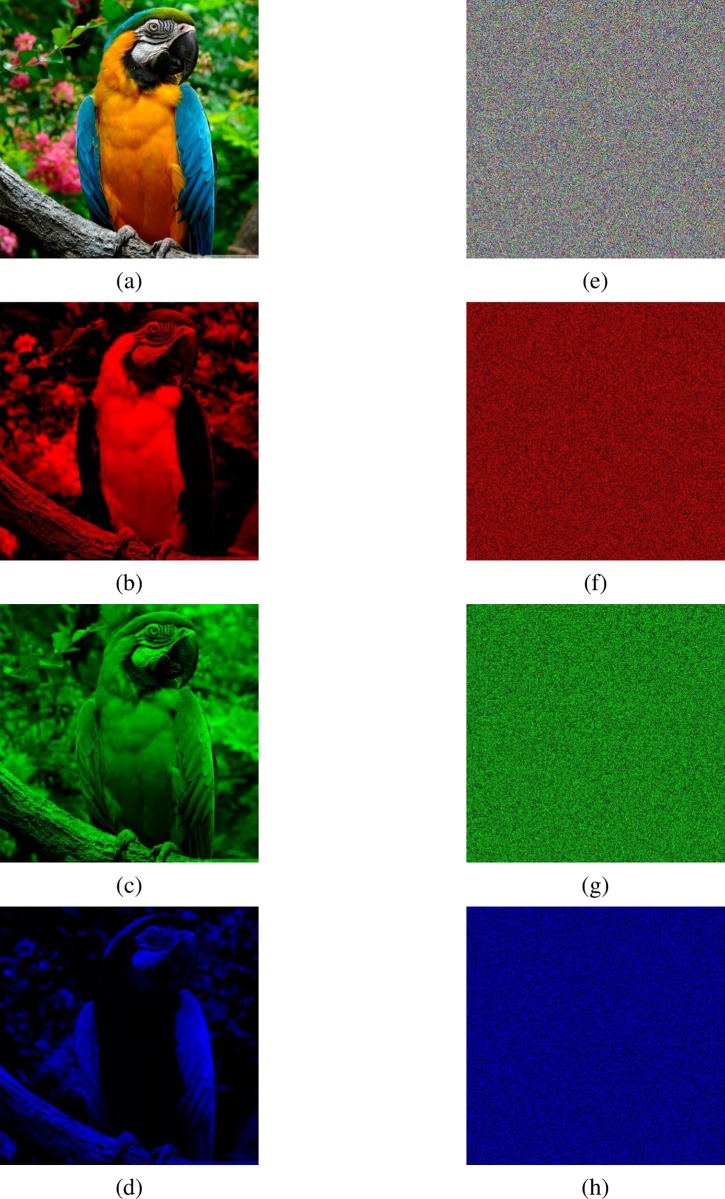
Plain and encrypted layer wise images of Parrot.(a) plain Parrot image. (b) Red component. (c) Green component. (d) Blue component. (e) Encrypted Parrot image. (f) Encrypted Red component. (g) Encrypted Green component. (h) Encrypted Blue component.